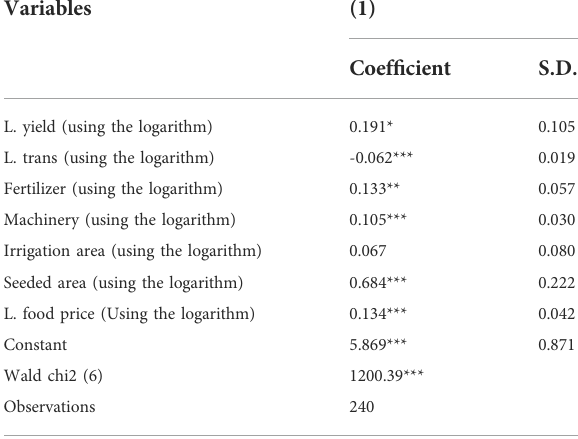
TABLE 3 Impact of ALT on grain output in